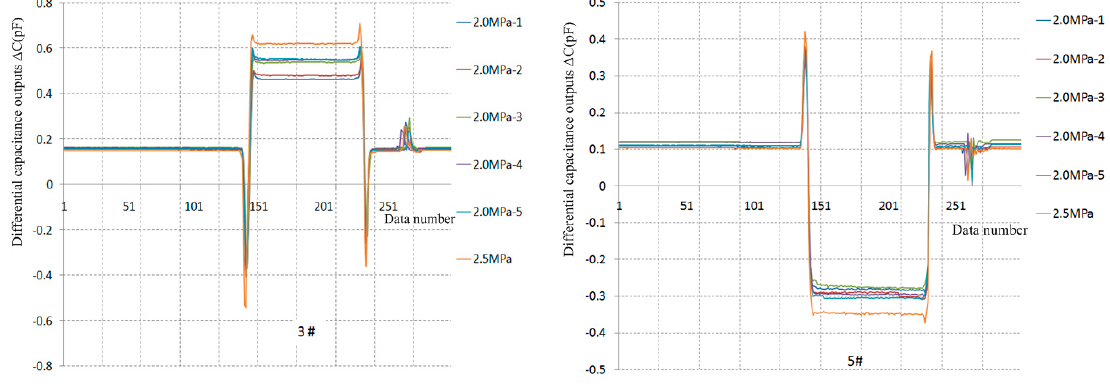
Figure 13. Repeatability test curves in turbulent flow conditions.